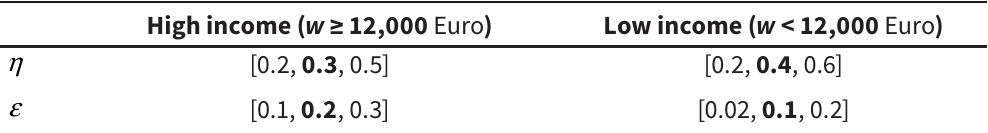
Note : non bolded values represent intervals while bolded variables represent the chosen point